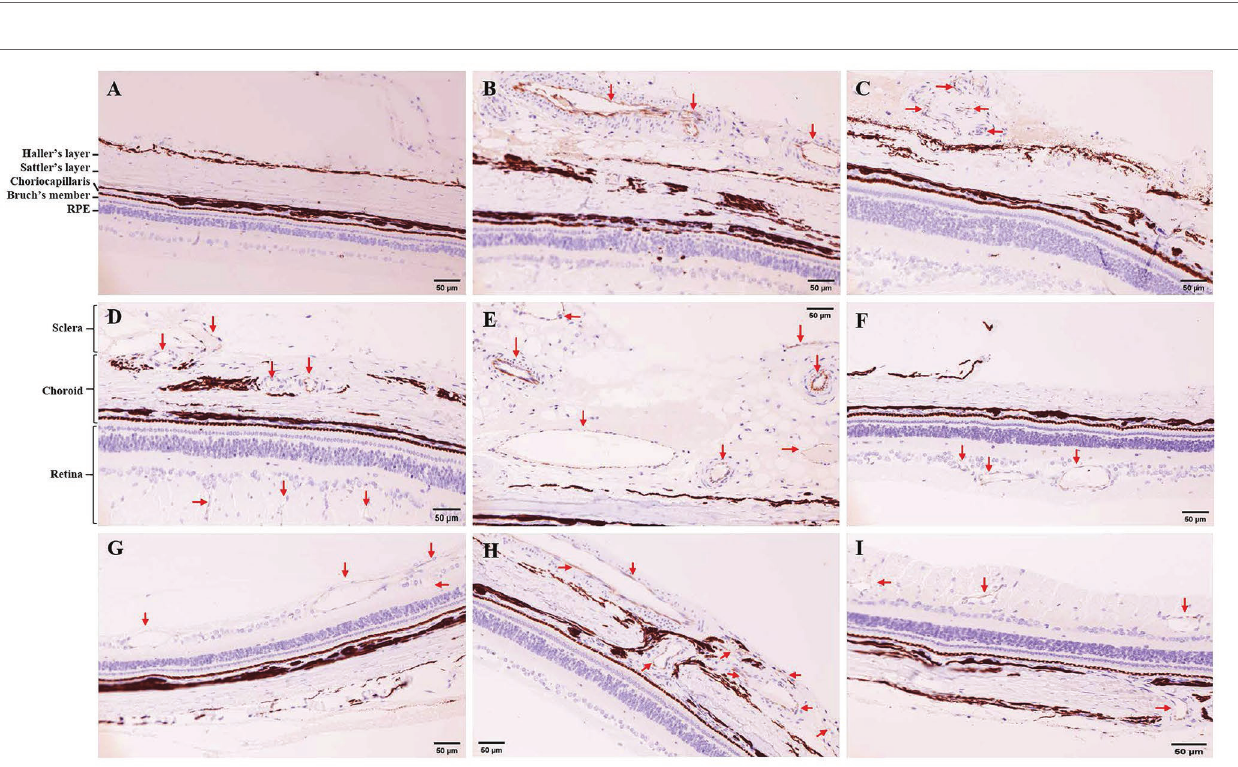
FIGURE 2 | Immunohistochemistry (IHC) for CD31 in tree shrew retina and choroid (200×). (A) IHC in control group. (B,C) IHC in 7 days of photocoagulation group. (D,E,F) IHC in 14 days of photocoagulation group. (G,H,I) IHC in 21 days of photocoagulation group. The red arrow indicates neovascularization. RPE, Retinal pigment